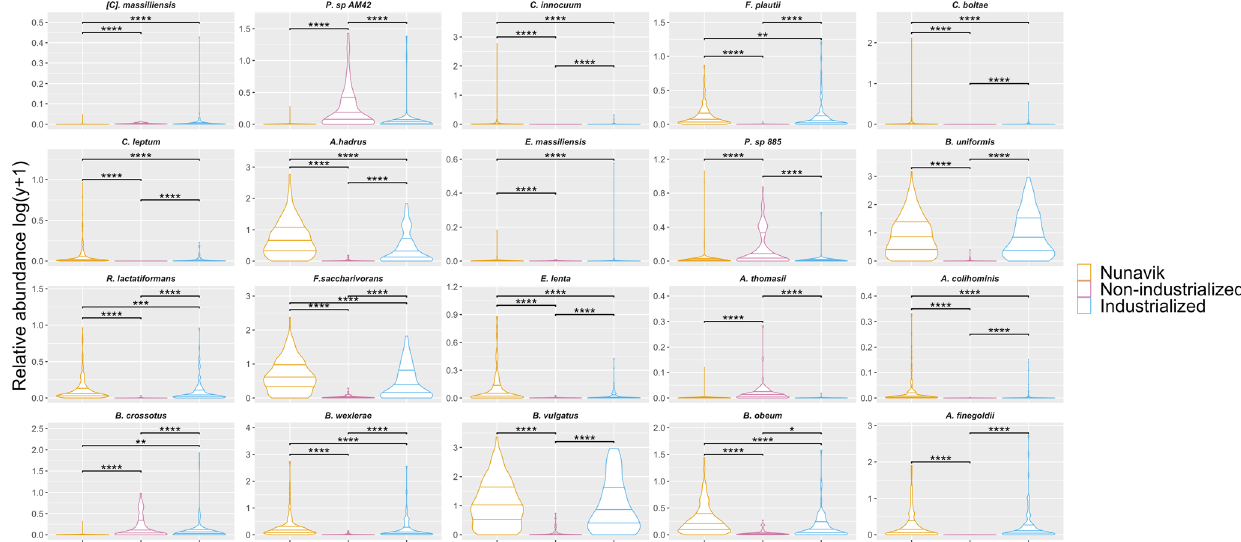
Fig. 5 Top 20 Random Forest (RF) identi fi ed species that discriminate between Nunavik, non-industrialized and industrialized gut microbiome. Violin Plots represent the relative abundance (in copies per million, cpm) of RF identi fi ed species distinguishing between Nunavik and comparison microbiome (Wilcoxon-Mann-Whitney). (* p -value ≤ 0.05, ** p -value ≤ 0.01, *** p -value ≤ 0.001, **** p -value ≤ 0.0001).